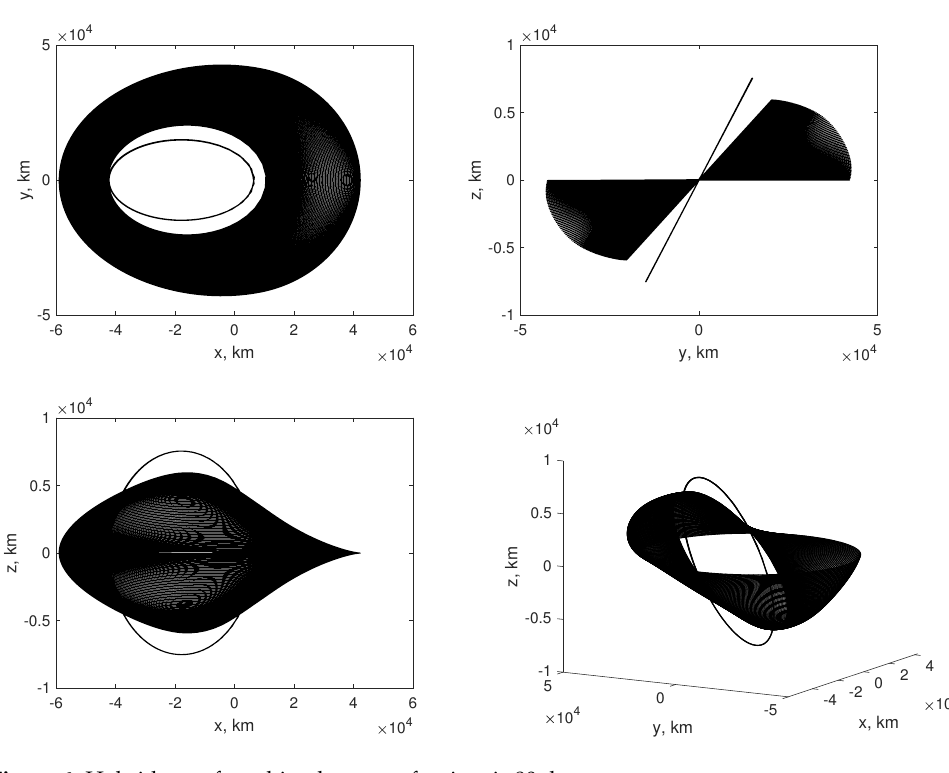
Figure 6. Hybrid transfer orbit when transfer time is 80 days.